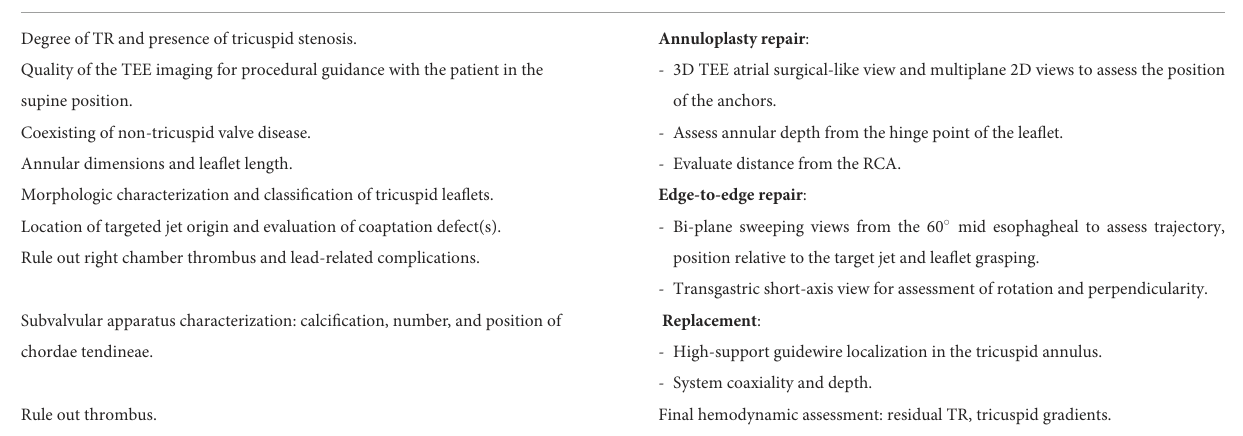
TABLE 1 Basic features concerning TEE and TTVi. Pre-procedural